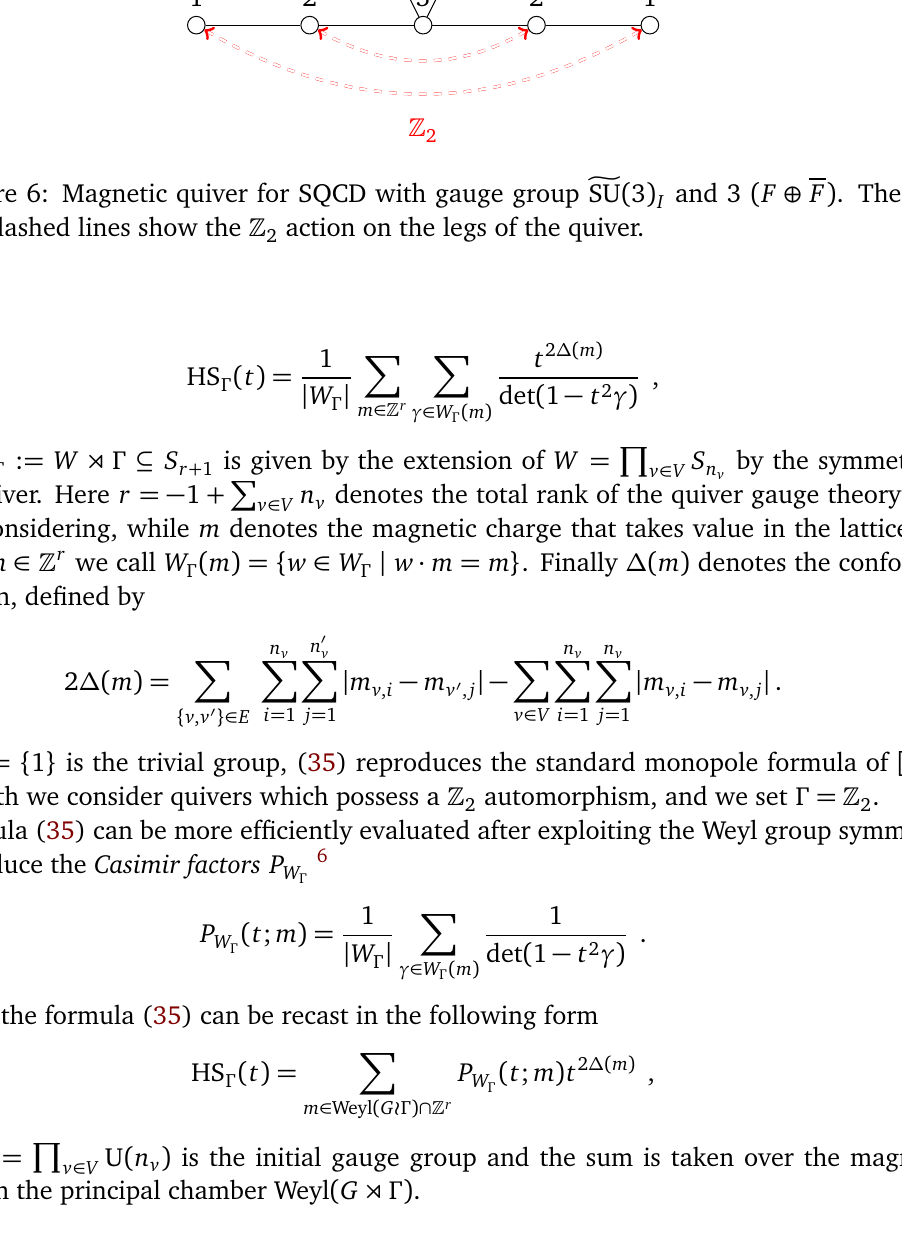
and 3 ( F ⊕ F ) . The I